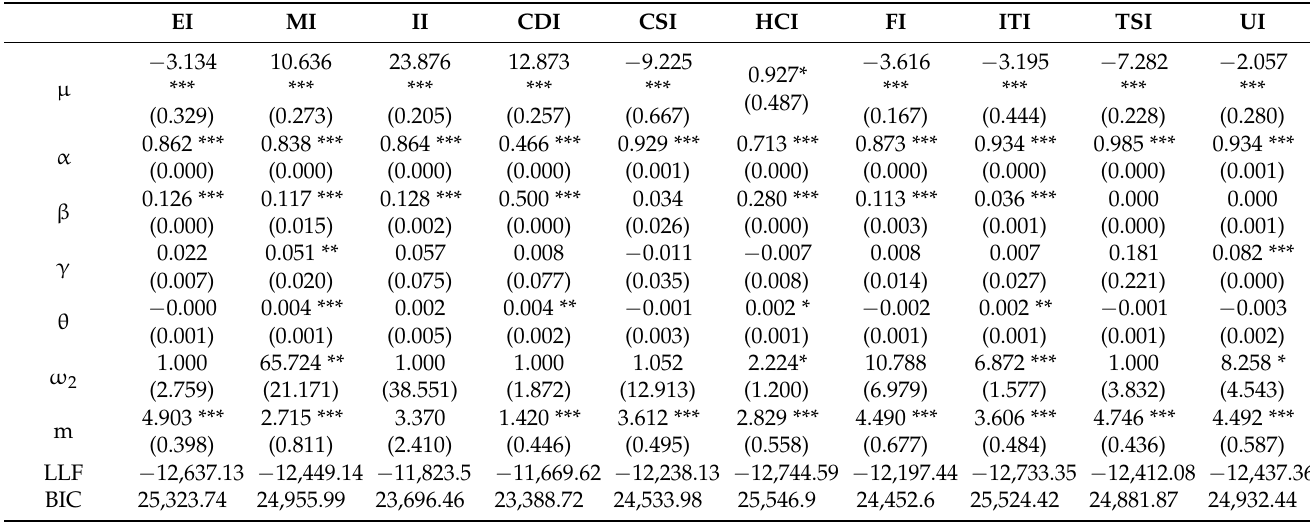
Table 11. GARCH-MIDAS regression results of EPU_CN index on volatility spillover levels of various industries in China 9 .